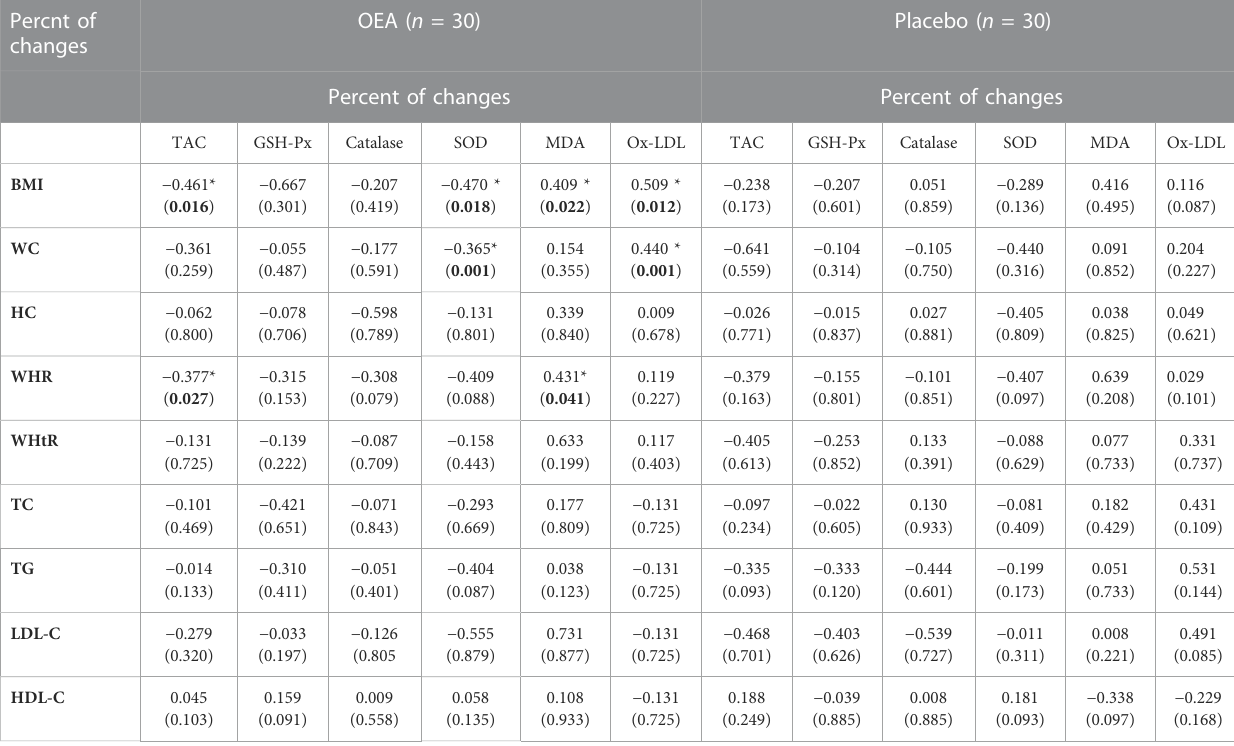
TABLE 4 Correlation coef fi cients among serum oxidative stress and antioxidant parameters and anthropometric indices and metabolic parameters. Percnt of